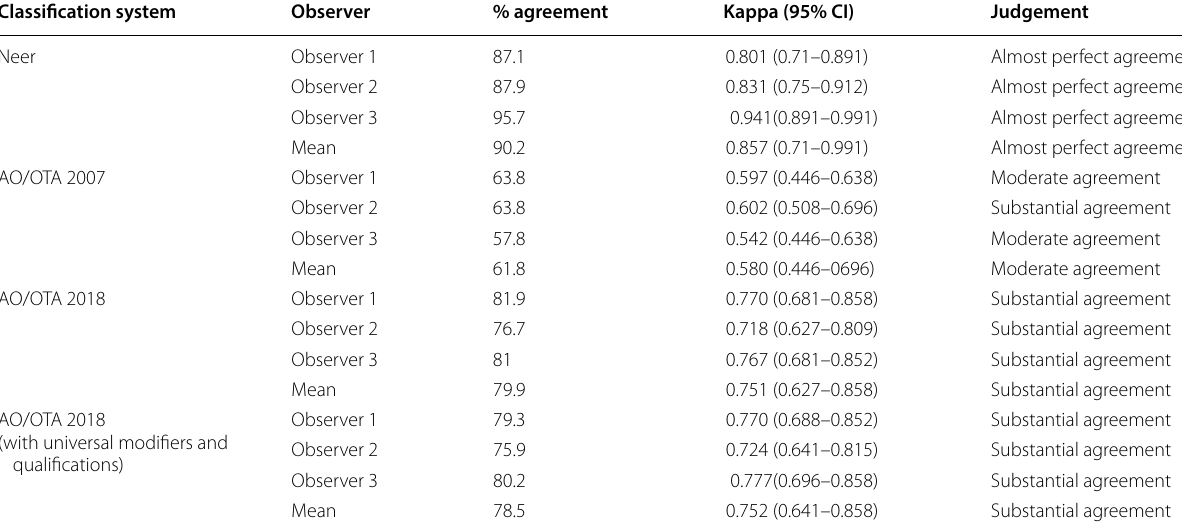
Table 6 Intraobserver reliability for individual reviewers for each system Classification system